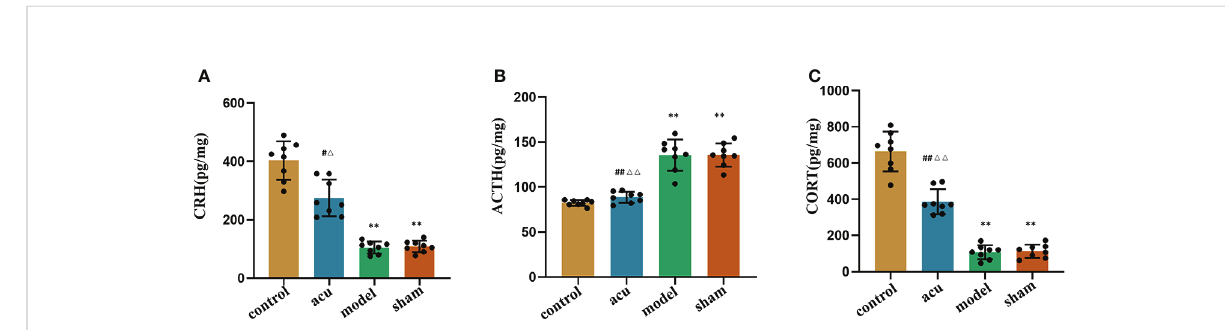
FIGURE 4 Acupuncture treatment improves the dysfunction of HPA axis in CRF mice after chemotherapy for BC. ELISA was used to detect the protein content changes of HPA axis-related factors CRH (A) , ACTH (B) and CORT (C) in the serum. n = 8 mice in each group. ** P < 0.01 versus control group; # P < 0.05 versus model group, ## P < 0.01 versus model group; △ P < 0.05 versus sham group, △△ P < 0.01 versus sham